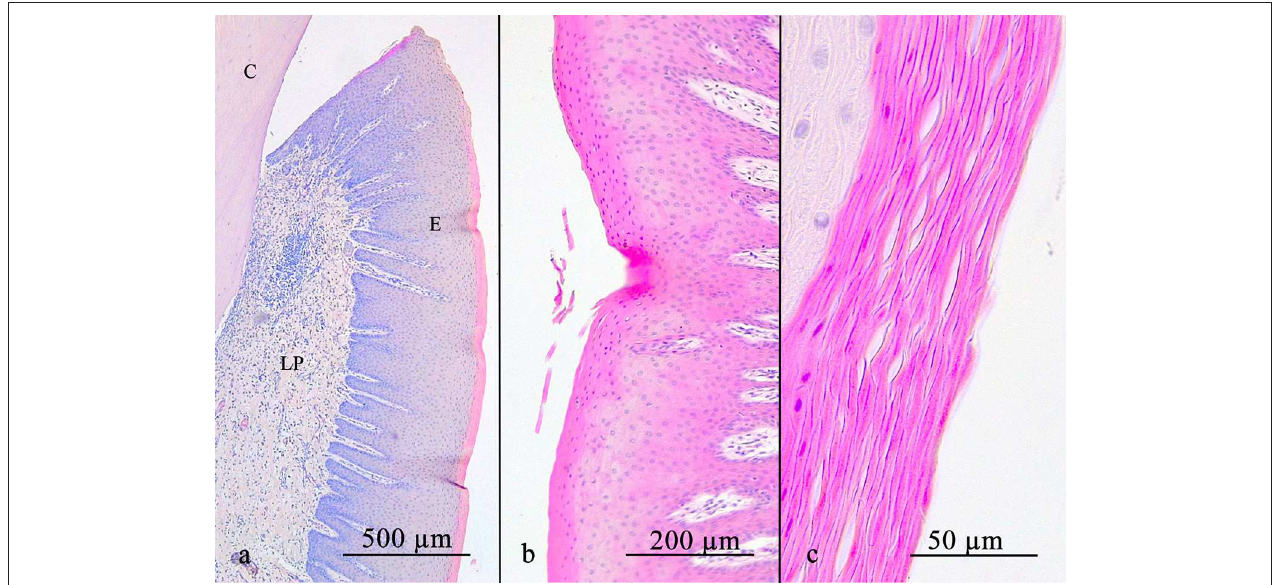
FIGURE 3 | The gingival sulcus was measured from the gingival margin to the suspected bottom of the gingival sulcus (a) . The average depth was < 1mm. The sulcular epithelium is a non-keratinized epithelium (b) . Leucocytic infiltrates are able to get through the sulcular epithelium, as shown in (c) . Rete pegs are visible (d) (arrows). C, cementum; JE, junctional epithelium; SE, sulcular epithelium; OE, oral epithelium; LP, lamina propria.